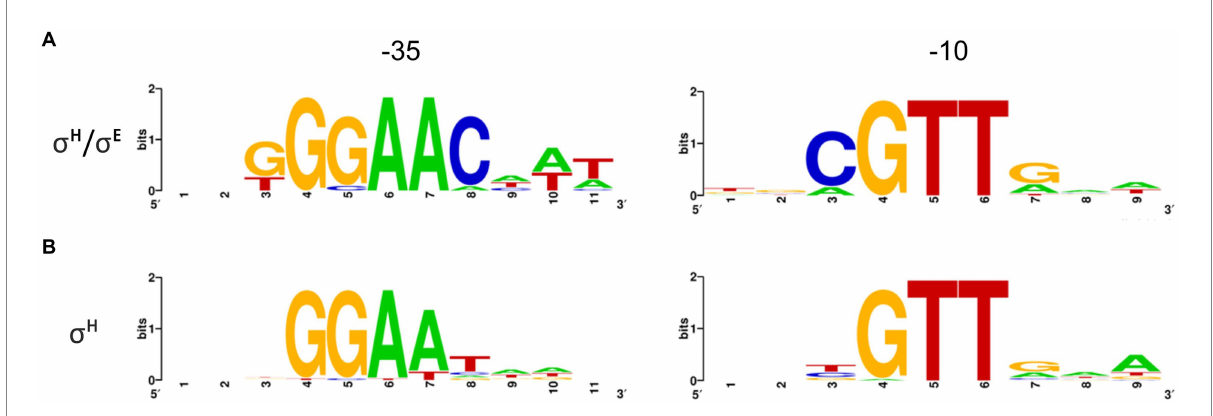
FIGURE 9 Consensus sequences of σ Η / σ E -dependent (A) and σ Η - dependent (B) promoters defined by Weblogo. Promoters (nt sequences − 1 to − 50) were aligned at the highly conserved GTT trimer corresponding to the − 10 element. σ Η / σ E 16 sequences; σ Η 44 sequences. Sequence logos were made with Weblogo3 (Crooks et al.,